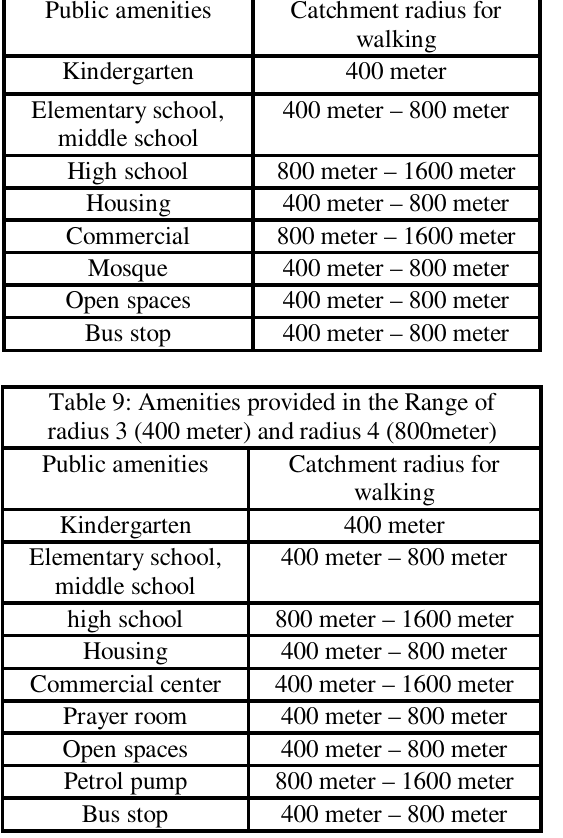
Table 8: Amenities provided the range of radius 1 (400 m) and radius 2 (800m)